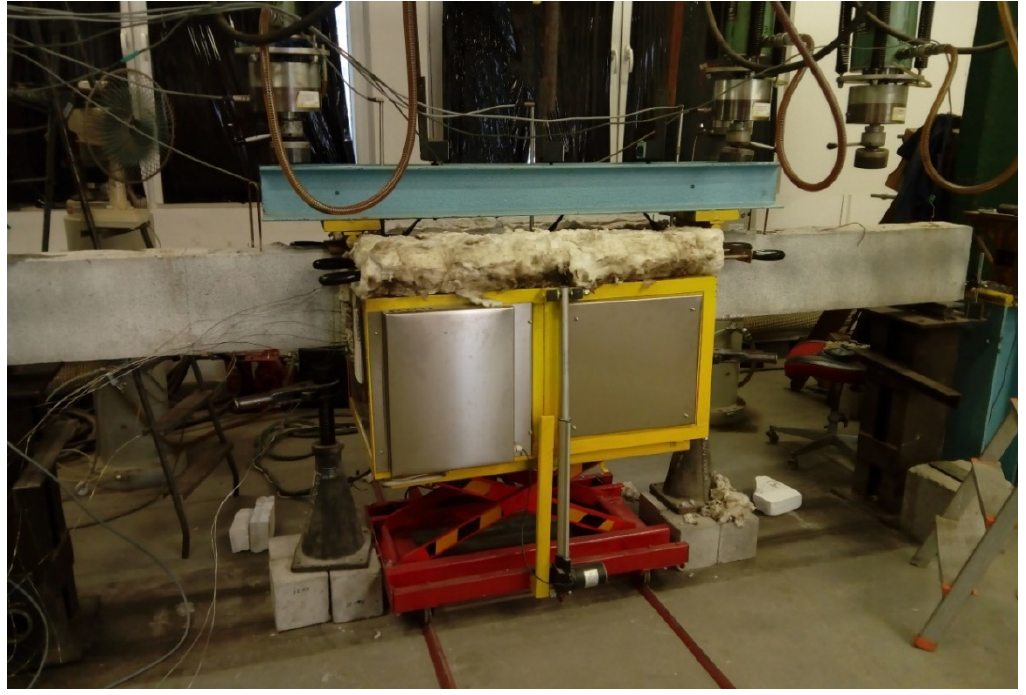
Figure 4. Test setup during heating